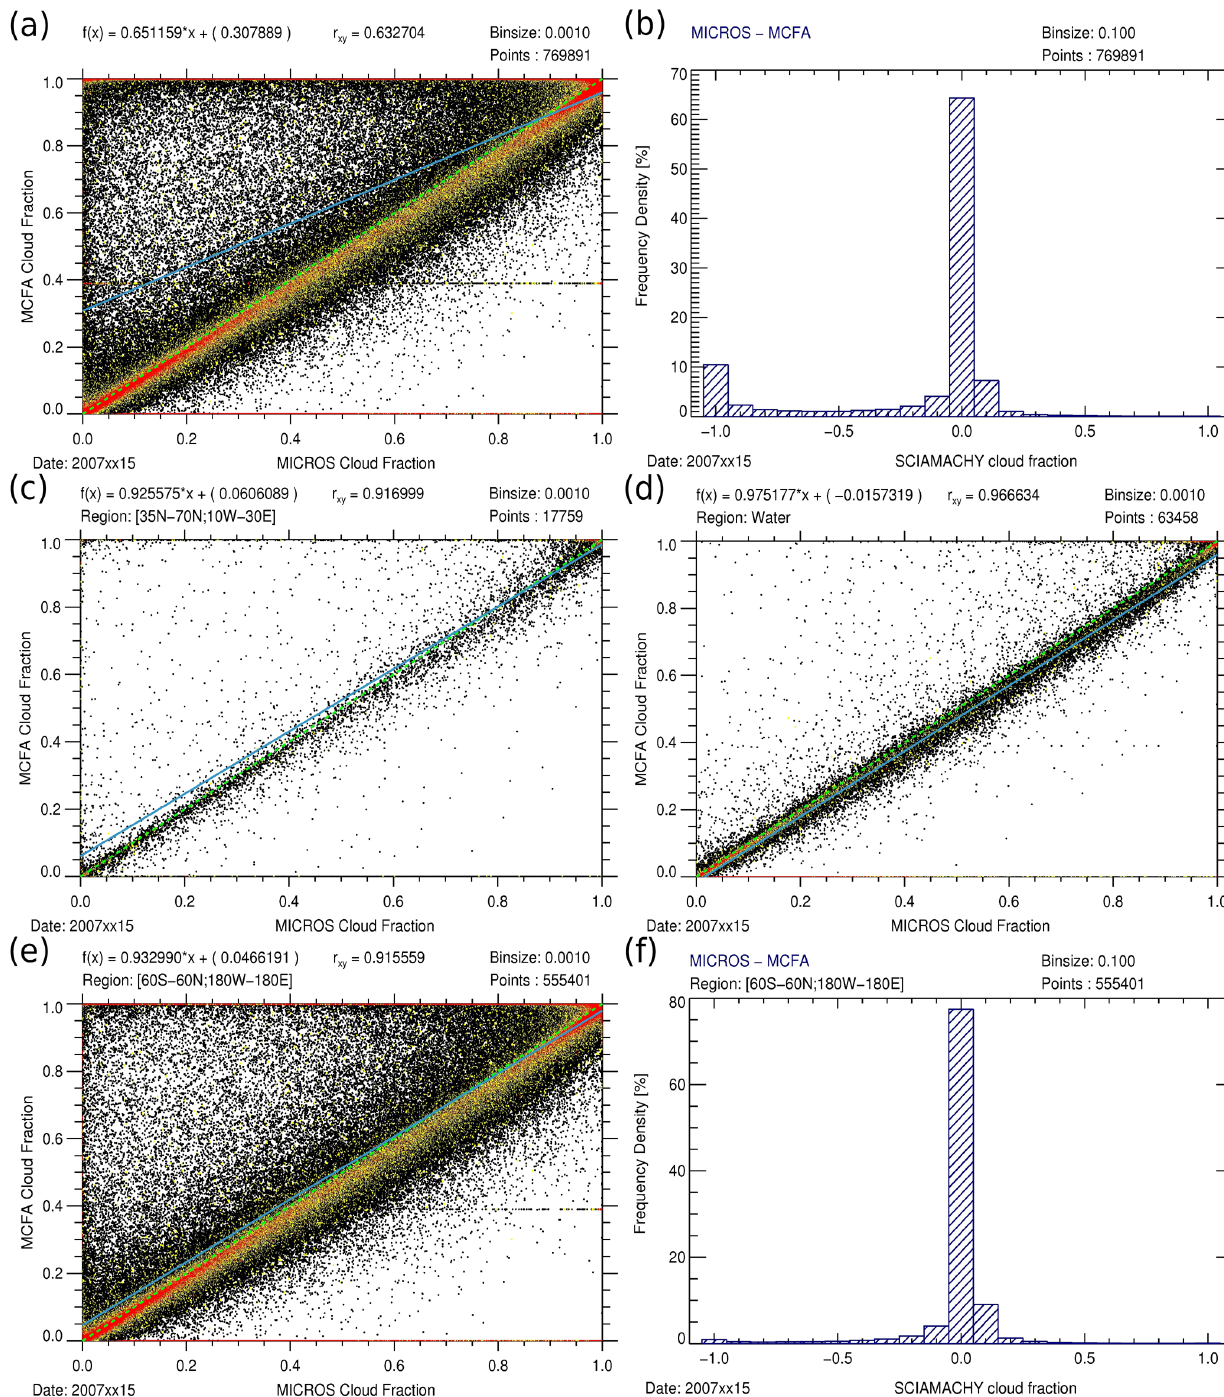
Fig. 8. Intercomparison of SCIAMACHY cloud fractions (optically thick clouds) derived from the MICROS and MCFA algorithms consid- ering each 15th in 2007: (a) Cross-validation for all cloud fractions, (b) difference histogram with respect to (a) , (c) cloud fractions over Europe [35 ◦ N–70 ◦ N; 10 ◦ W–30 ◦ E], (d) cloud fractions over water, (e) cloud fractions at mid- and low-latitudes [60 ◦ S–60 ◦ N; 180 ◦ W– 180 ◦ E] and (f) difference histogram with respect to (e) . The colour code of the two dimensional density function plots [ (a) , (c) , (d) , (e) ] is the following: If only one measurement is located inside of a bin, the result is coloured in black. If more than 1 but less than 4 measurements are located inside of a bin, the result is coloured in yellow. If more than 4 measurements are located inside of a bin, the results is coloured in